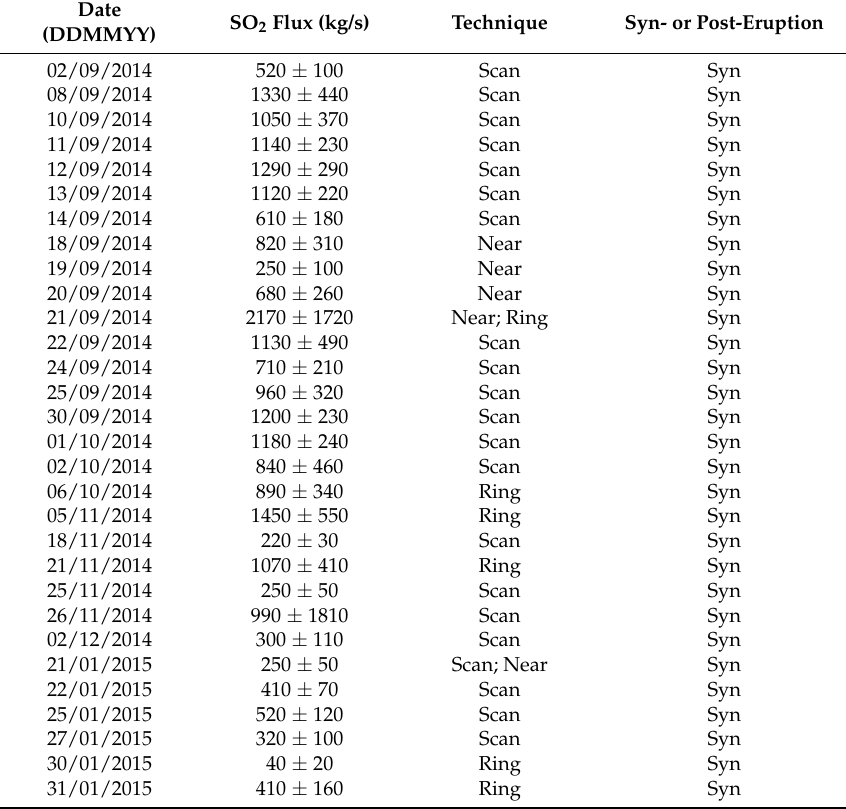
Table 1. Daily average DOAS measurements of SO 2 flux, distinguished by measurement technique and if the measurement occurred during or after the